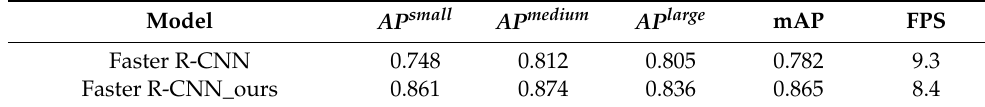
Table 2. Results of the comparative experiments before and after the improvement of the algorithm. Model